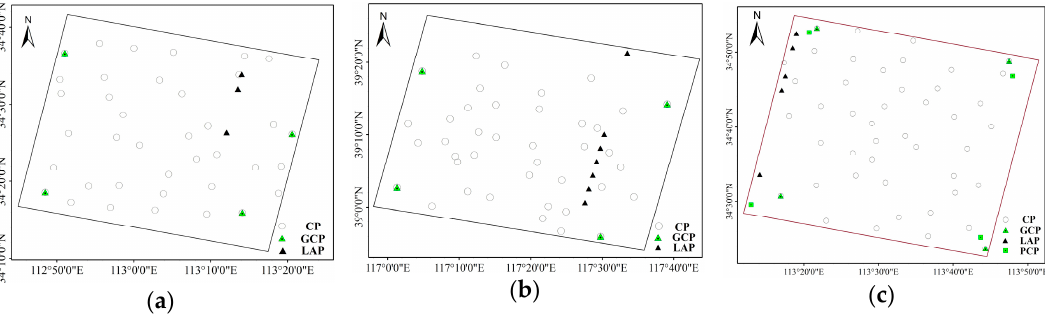
Figure 8. Schematic diagram of the points’ (CPs, GCPs, LAPs) distribution in ( a ) Songshan, ( b ) Tianjin and ( c ) Dengfeng.